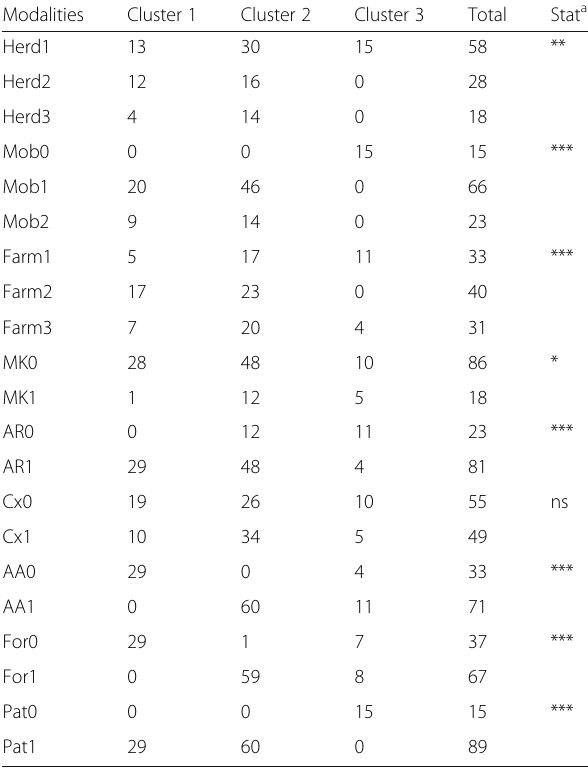
Table 6 Characteristics of farmers in the three clusters by